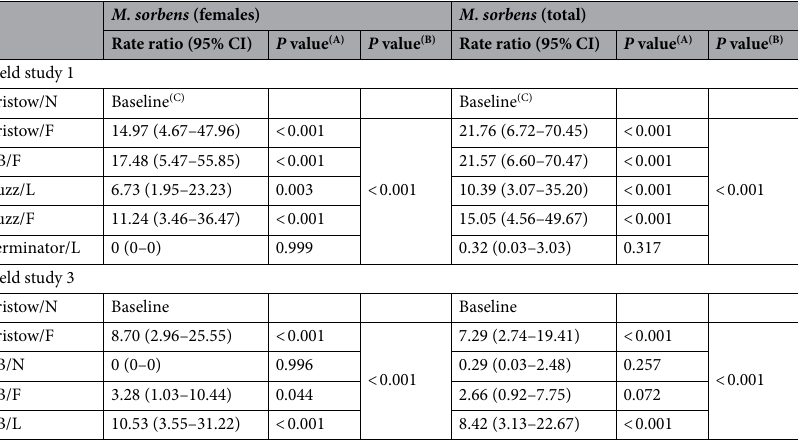
Table 2. Female and total M. sorbens caught by different trap types across field studies one and three. Trap types are: Bristow trap/negative (Bristow/N; no bait), Bristow/faeces (Bristow/F), Bickford Bucket/ faeces (BB/F), The Buzz/The Buzz lure (Buzz/L), The Buzz/faeces (Buzz/F), Terminator/Terminator lure (Terminator/L), Bickford Bucket/negative (BB/N) Bickford Bucket/ The Buzz lure (BB/L). Too few M. sorbens were caught in field study 2 to warrant statistical analysis. (A) P -value comparing this category with baseline. (B) P -value testing hypothesis that trap type is associated with number of flies trapped. (C) Analysis adjusted for Day.